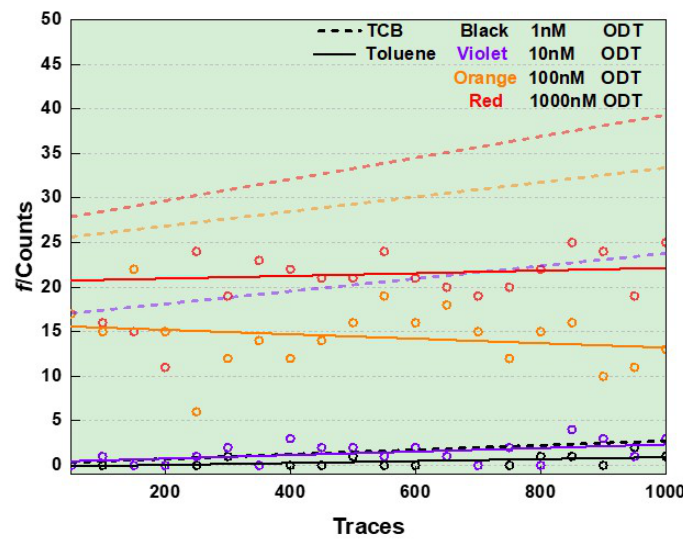
Figure 8. Solvent dependence of the formation probability f of ODT junctions. Solid and dashed lines are linear fits to the plots.